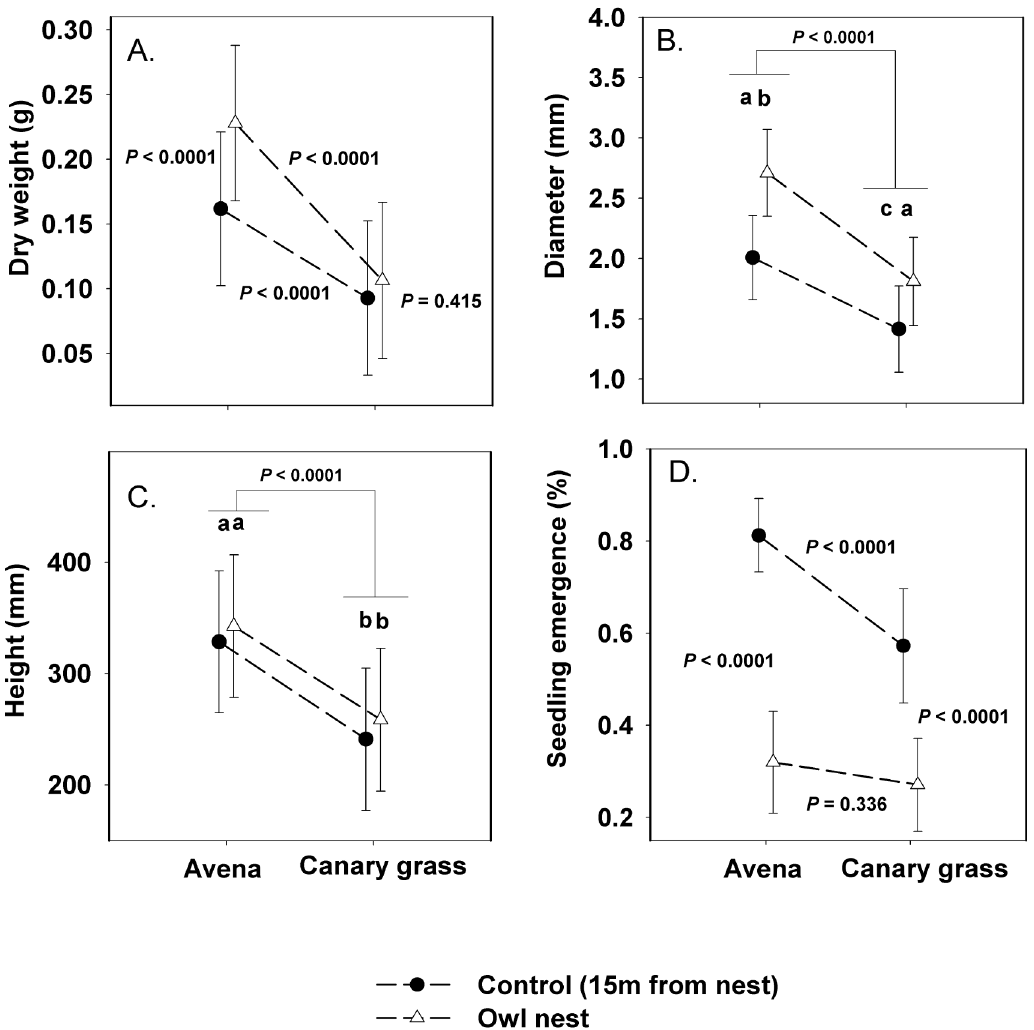
Fig 2. Effect of owl nest on seedling size and emergence. Model-adjusted means ( ± 1 SE) of different seedling size variables (A, weight; B, diameter; C, length) and the percentage of emergence (D). When the interaction between two variables was significant (A, C), we report the P -values of the tests for the four simple main effects involved in the interaction. Different letters denote significant